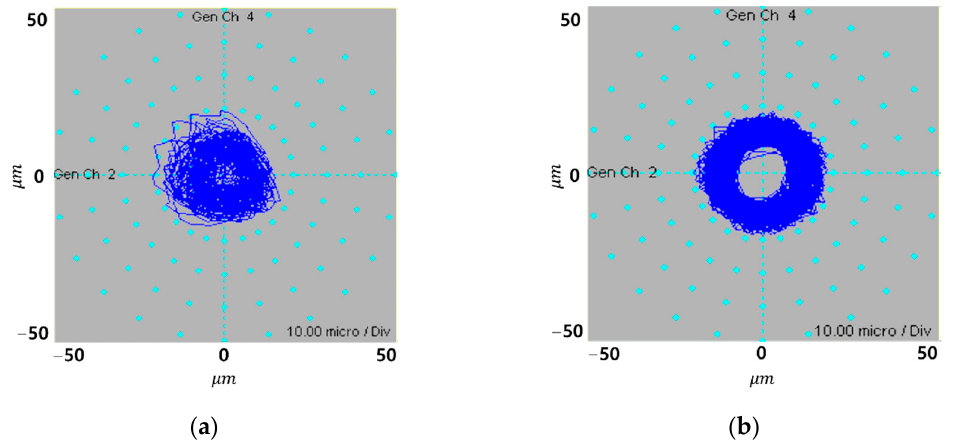
Figure 2. Magnetic bearing operation data from the Korea Atomic Energy Research Institute (KAERI) and Korea Advanced Institute of Science and Technology (KAIST): ( a ) under S-CO 2 conditions at 14,000 rpm (43.42 °C, 78 bar); ( b ) under room temperature and pressure at 30,000 rpm [12].